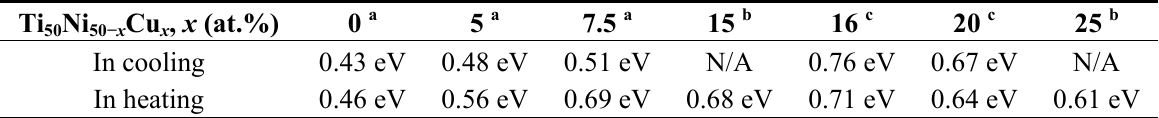
Table 2. The activation energy ( E heating